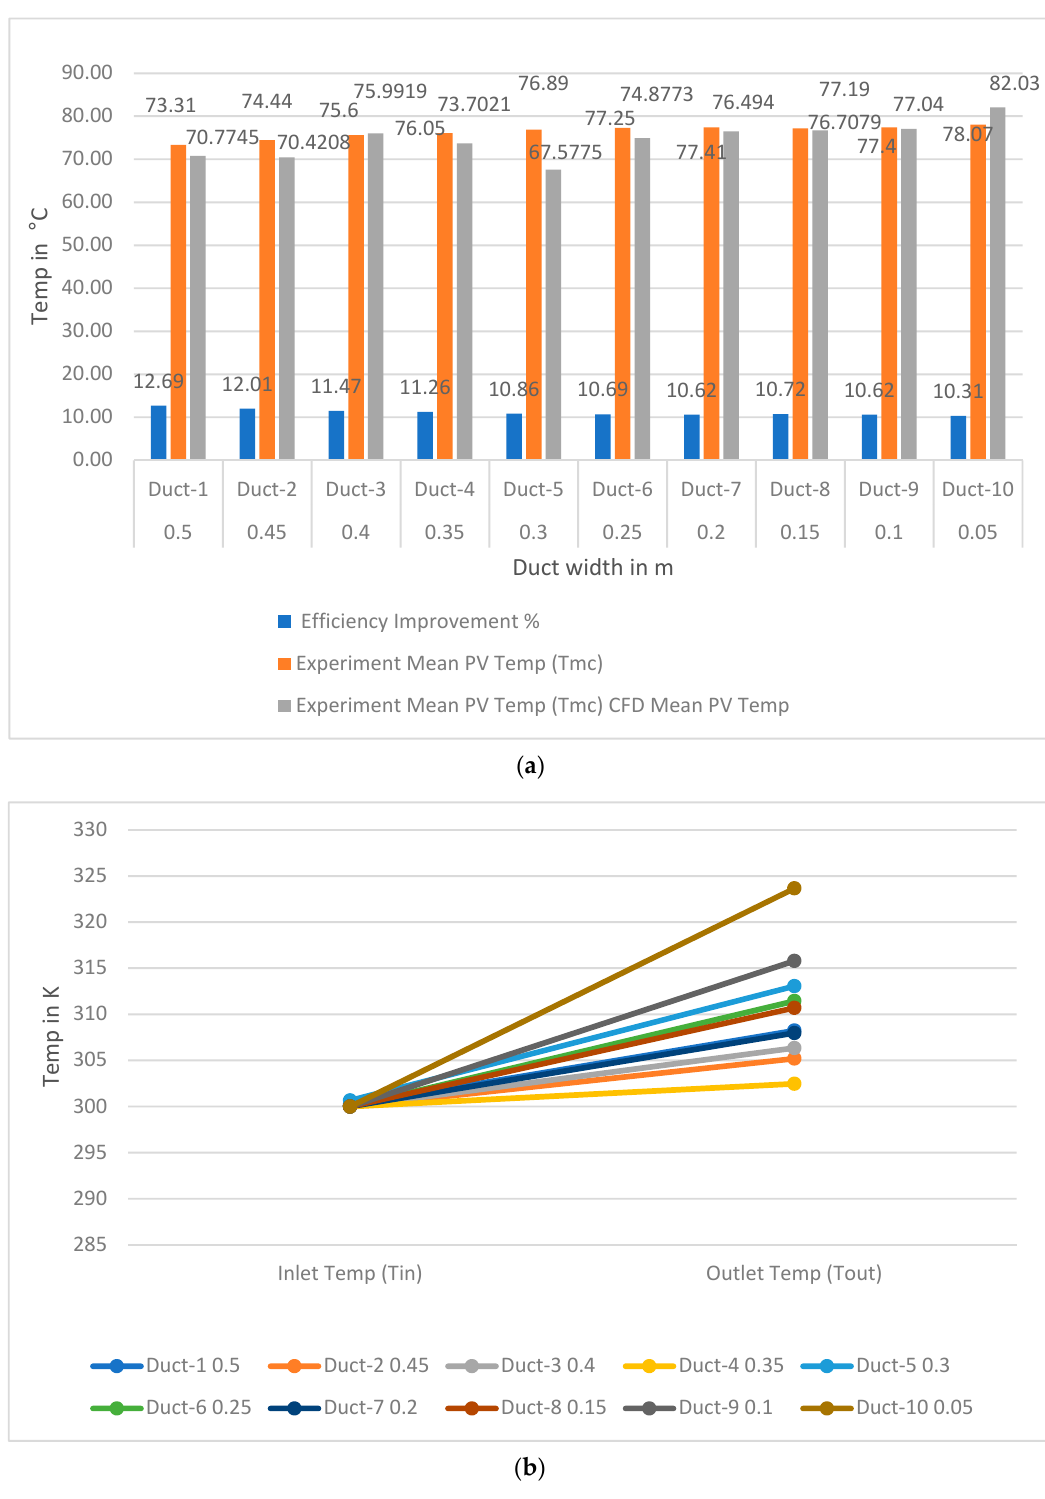
Figure 5. ( a ) Comparison between the experimental and simulated results of the mean cell temperatures; ( b ) plots of the average air temperature from the inlet to the outlet of the duct for all duct widths simulated .